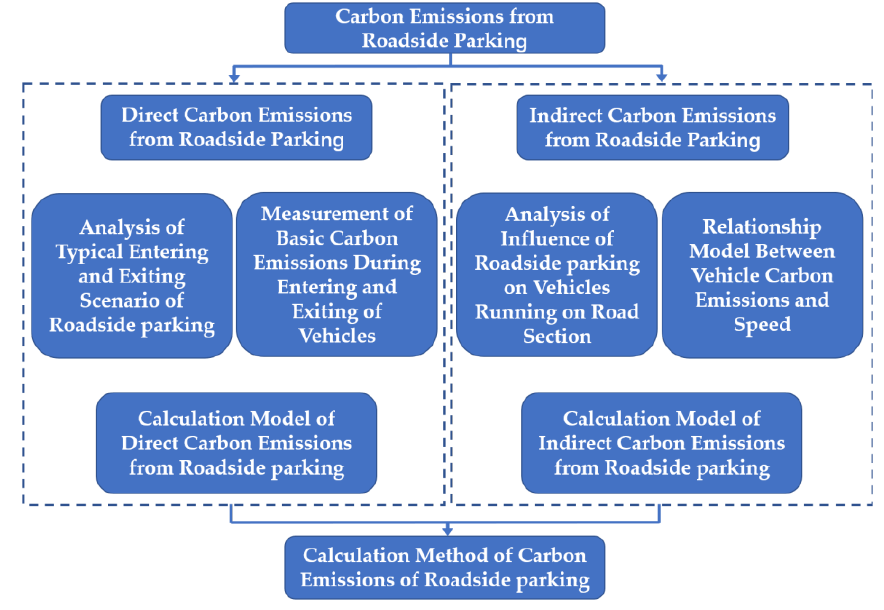
Figure 1. Research step diagram of the thesis.